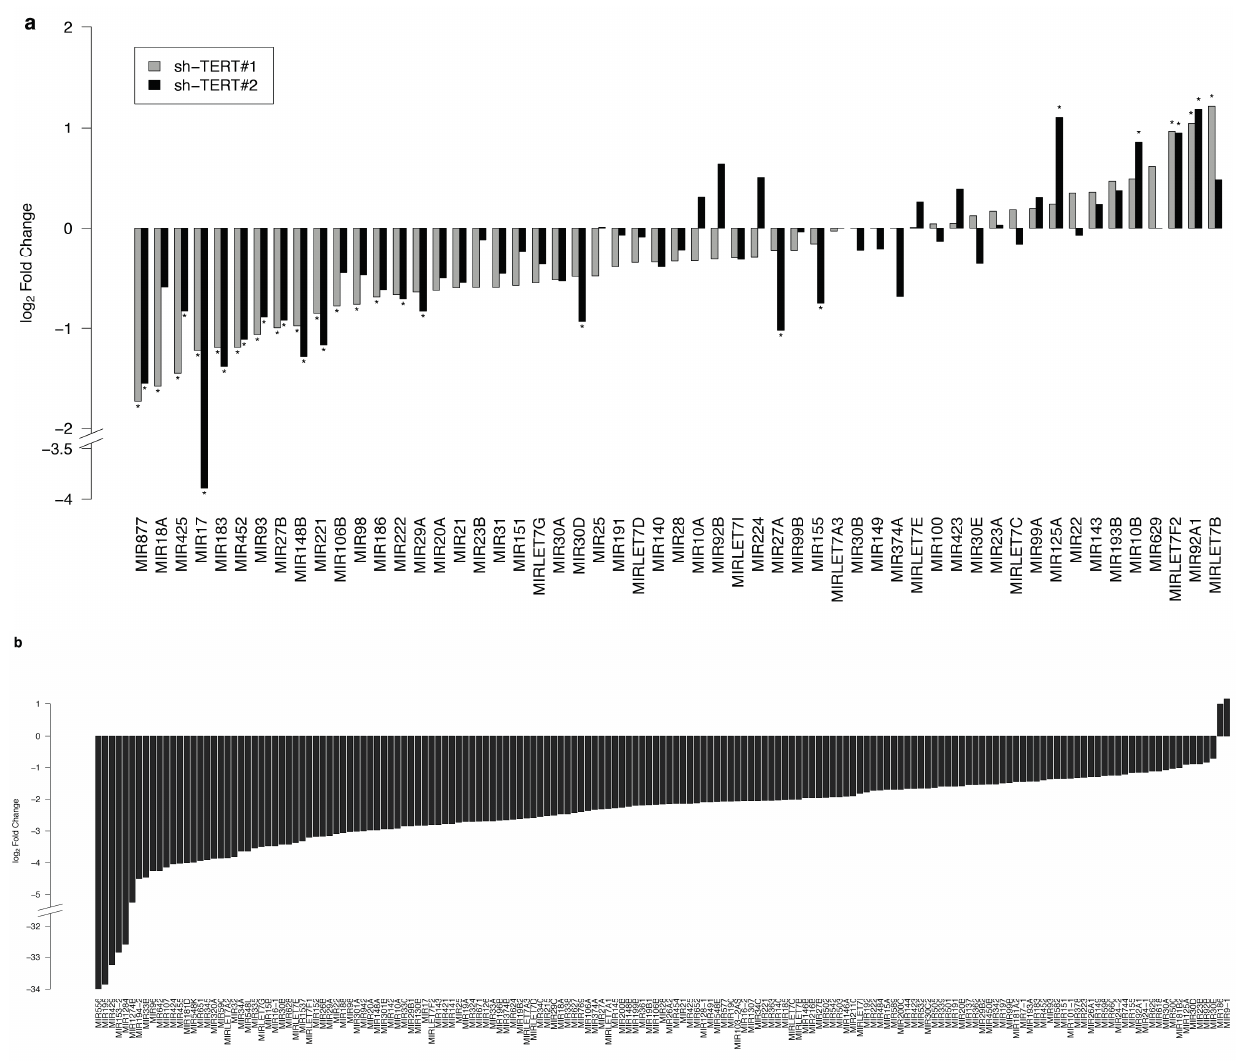
Figure 1. Mature miRNAs are regulated by TERT. Fold changes in miRNA expression measured by sequencing in HeLa cells ( a ) and THP-1 cells ( b ). Bars highlighted with asterisks represent statistically-significant changes. In HeLa cells, the changes were measured using sh-TERT#1 (gray) and sh-TERT#2 (black). In THP-1 cells, the changes were measured using a siRNA targeting